Question: State the chart type depicted above.
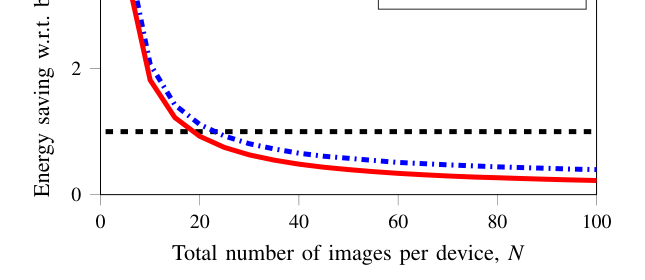
Answer: line